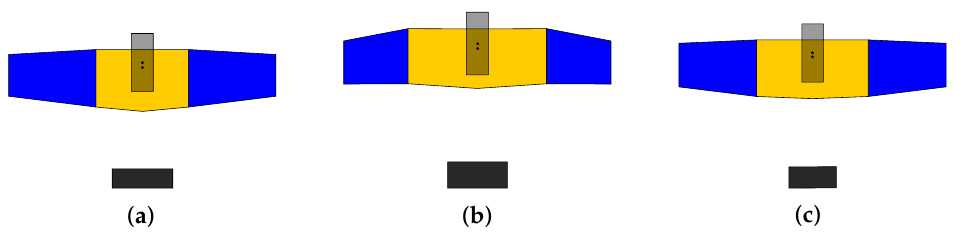
Figure 14. Best aircraft design obtained from each positive feedback strategy. ( a ) Strategy I, ( b ) Strat- egy II, ( c ) Strategy